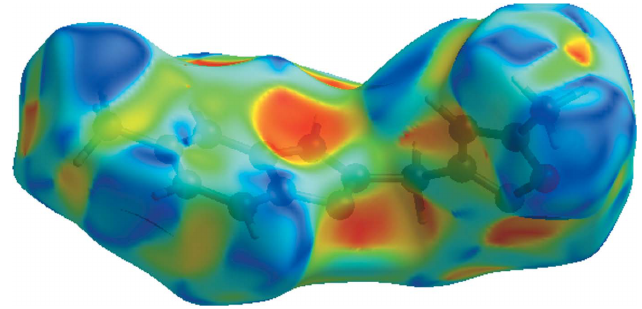
Figure 4 Hirshfeld surface of the title compound plotted over